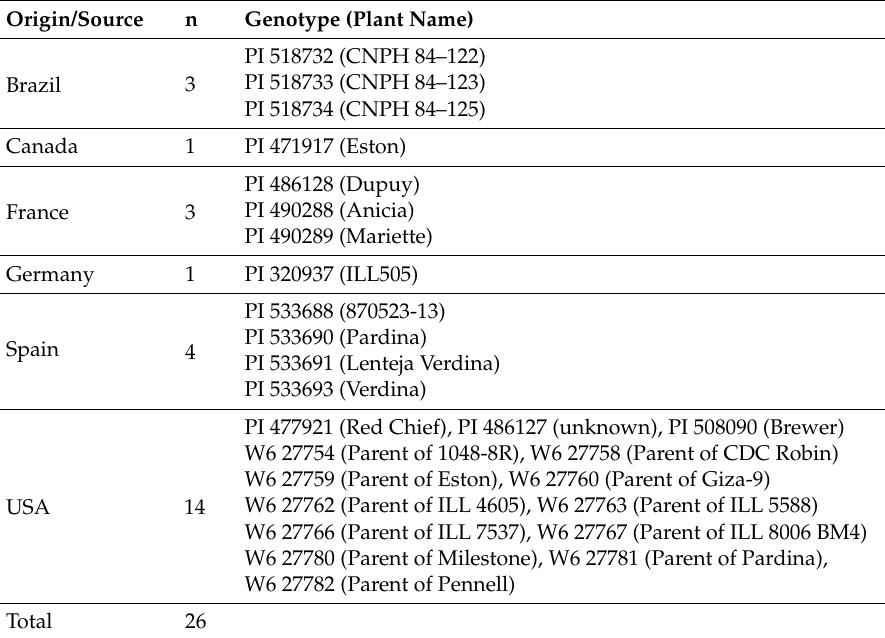
Table 1. Lens culinaris subsp. Culinaris genotypes used in the germination